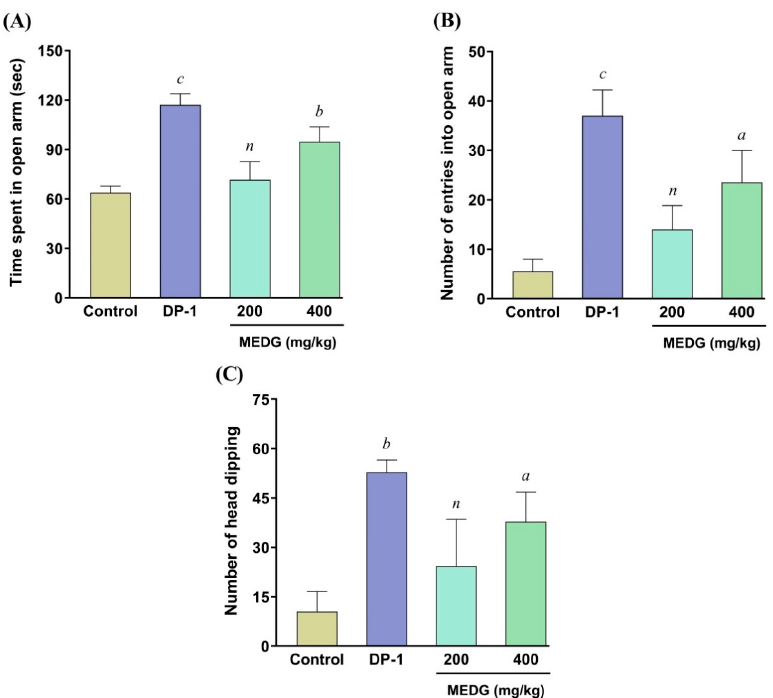
Figure 1. Effect of oral administration of MEDG on elevated plus maze test, time spent in open arm ( A ), the number of entries into open arm ( B ), and hole board test (C) in mice. The results were expressed as mean ± SEM, ( n = 6), and a p < 0.05, b p < 0.01, and c p < 0.001 were statistically significant and ( n ) = non-significant compared with the control group followed by Dunnett’s test (one-way ANOVA). DP = diazepam; MEDG = methanol extract of D. grandiflora stem barks.